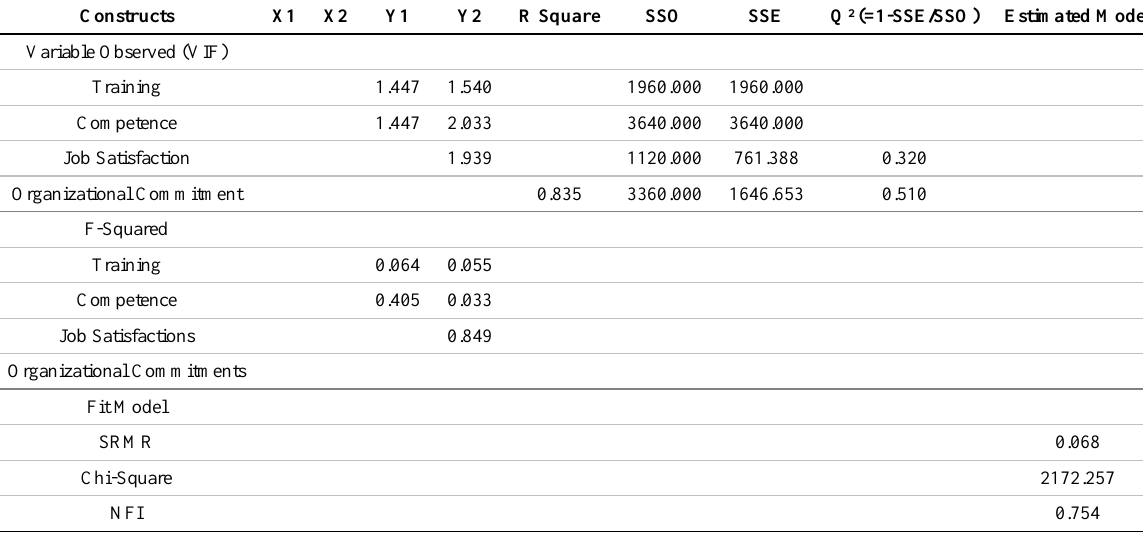
Table 3. Summary of Structural Model Results